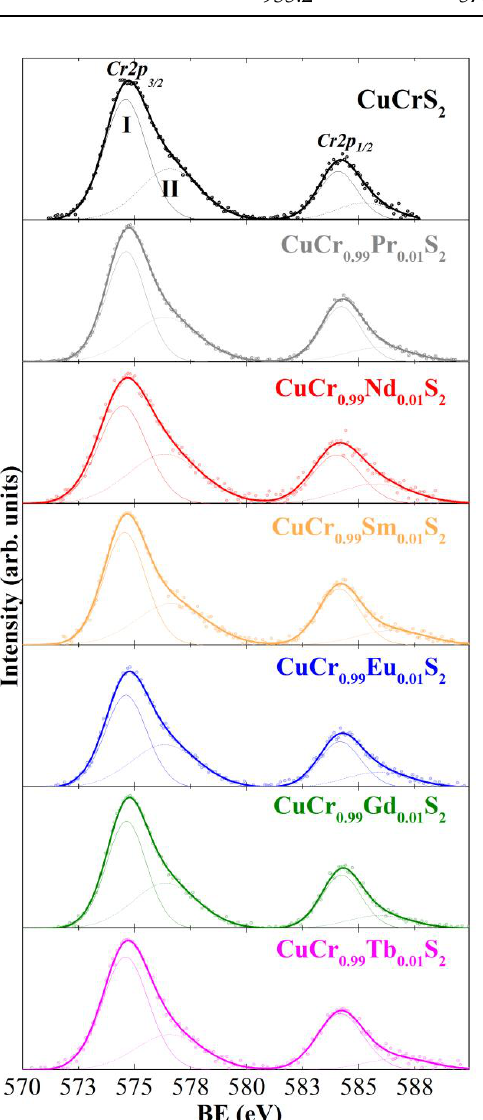
Figure 3. X-ray photoelectron Cr2p region for CuCrS 2 and CuCr 0.99 Ln 0.01 S 2 (Ln = Pr – Tb). The S2p region of the initial CuCrS 2 matrix and lanthanide-doped solid solutions is shown in Figure 4. The S2p line is unresolved peak arising due to spin-orbit coupling of S2p levels (denoted as S2p 1/2 - and S2p 3/2 in Figure 4, respectively). The S2p region exhibited two sets of lines. The first one (denoted as I in Figure 4) with BE of 161.1 – 161.5 eV arises from the sulfur atoms in the composition of the samples studied and corresponds to S 2 − state. The measured BE values is typical for transition metal sulfides (Cu 2 S (BE ≈ 161.8 eV), CuFeS 2 (BE ≈ 161.5 eV), TiS 2 (BE ≈ 160.9 eV) [36 – 39]). The high-energy component II with BE of ~163.0 eV arises from the sulfur atoms of polysulfide groups and elemental sulfur in the defective near-surface layers on the sample studied. However, the presence of the additional sulfur species on the sample surface is typical for the natural synthetic sulfides,